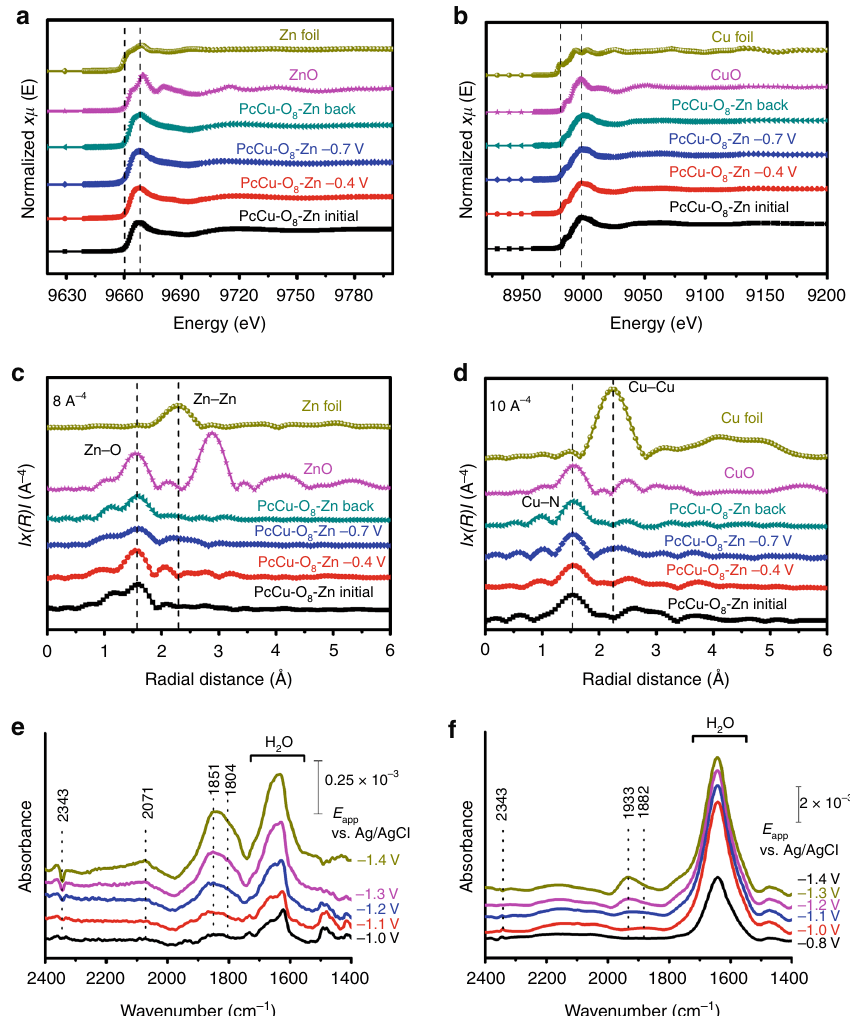
Fig. 4 Operando XAS and SEIRA measurement under electrolysis. a Zn K -edge XANES spectra of Zn foil, ZnO, PcCu-O 8 -Zn samples. b Cu K -edge XANES spectra of Cu foil, CuO, PcCu-O 8 -Zn samples. c Zn K -edge Fourier transform EXAFS spectra of Zn foil, ZnO and PcCu-O 8 -Zn samples. d Cu K -edge Fourier transform EXAFS spectra of Cu foil, CuO and PcCu-O 8 -Zn samples. e , f Operando SEIRA spectro-electrochemical analysis of PcZn-O 8 -Cu/CNT ( e ) and PcCu-O 8 -Zn/CNT ( f ) in CO 2 -saturated 0.1 M KHCO 3 . As reference, a SEIRA spectrum of the system at − 0.6 V vs. Ag/AgCl was